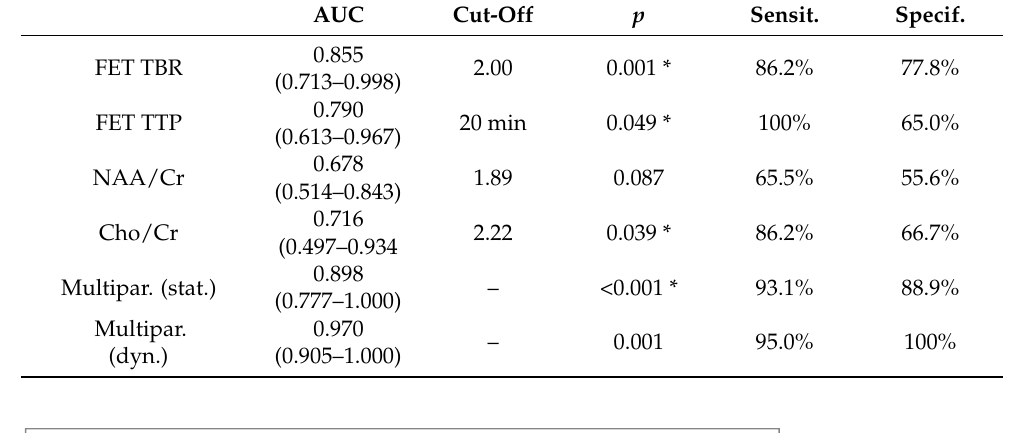
Table 2. Diagnostic accuracy of MRS and PET parameters for differentiation between low and high-grade gliomas. Significant results are marked with an asterisk. AUC Cut-Off p Sensit.